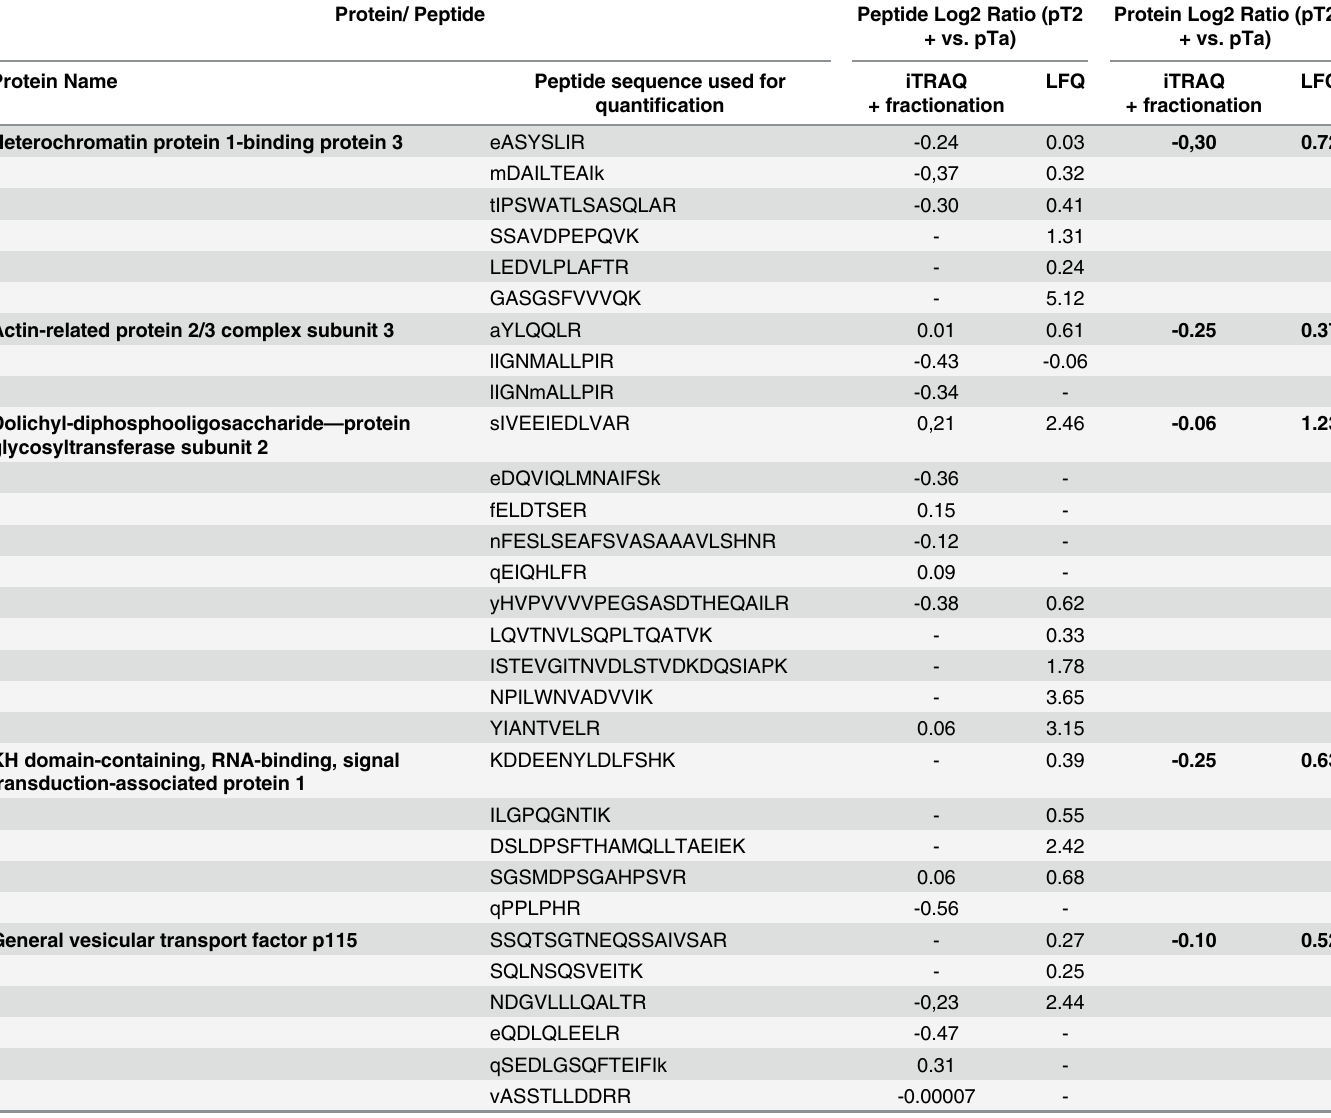
Table 5. Comparison of the quantification results at the peptide and protein level for identifications with conflicting expression trends between fractionated iTRAQ and LFQ Protein/